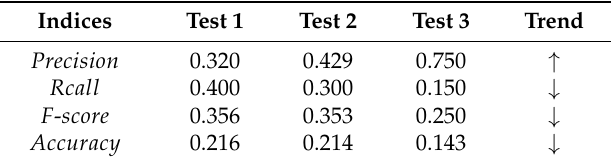
Table 4. The variation of Precision and Rcall via decreasing P l .